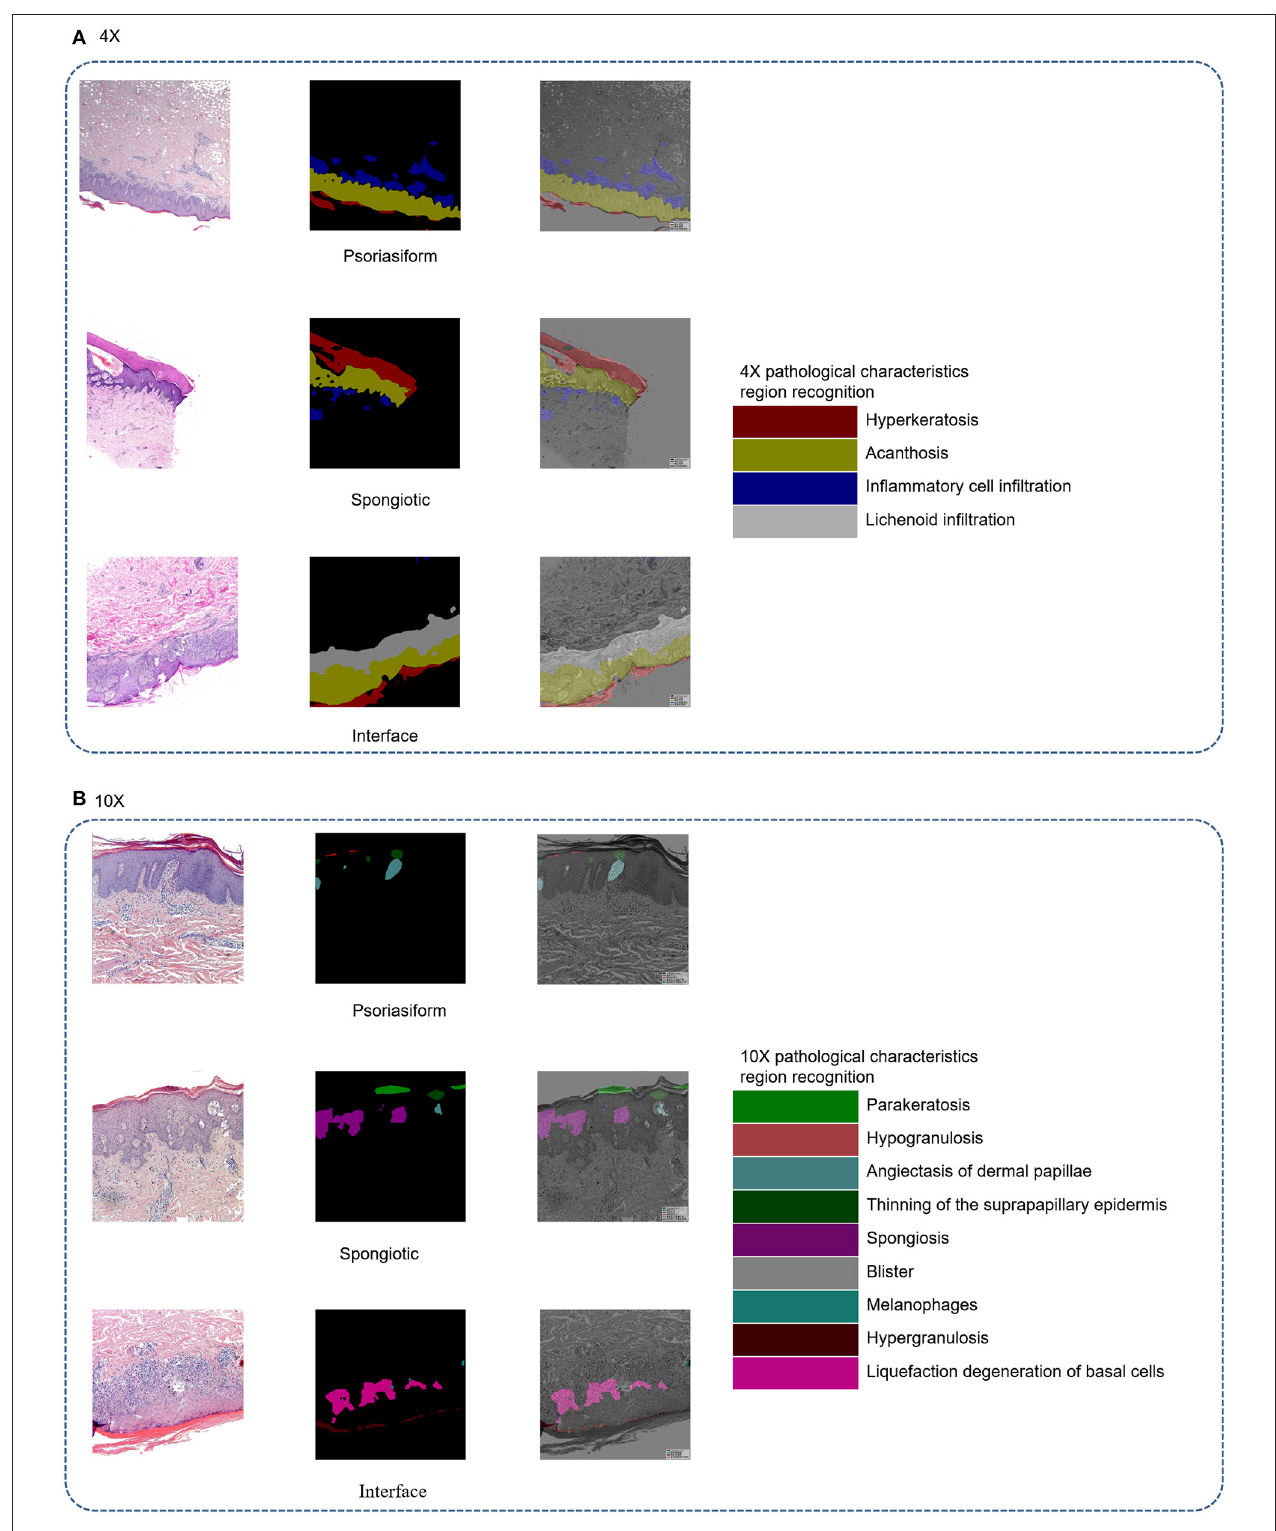
FIGURE 5 | Results of pathological characteristics region recognition.